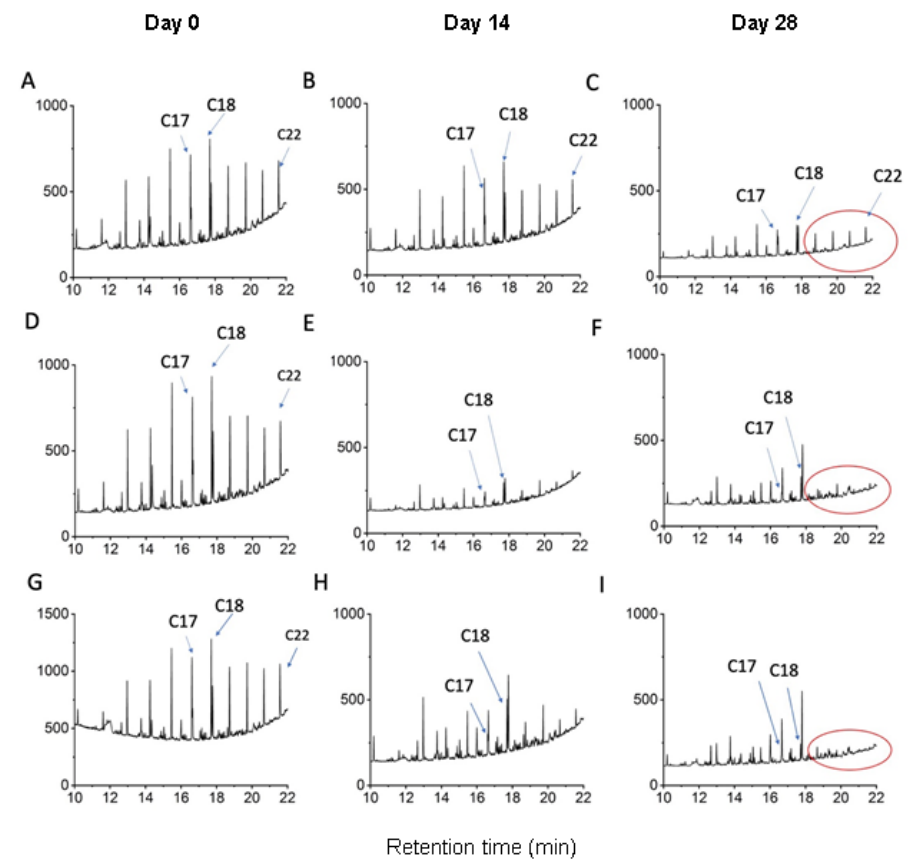
Figure 3. Gas chromatography–mass spectrometry (GC–MS) chromatograms of hydrocarbons ex- tracted from the control soils ( A – C ), soils bioaugmented with P. strains CT9 ( D – F ), and soils treated